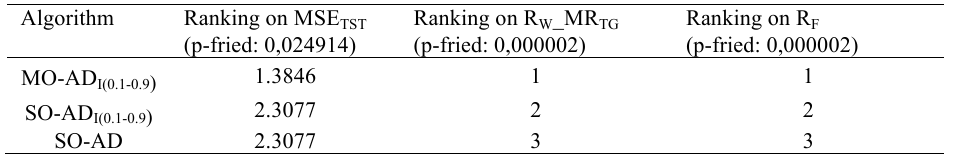
Table B.1 Rankings obtained through Friedman’s test for different values of thresholds on MSE TST , R W _AvR TG and #R F